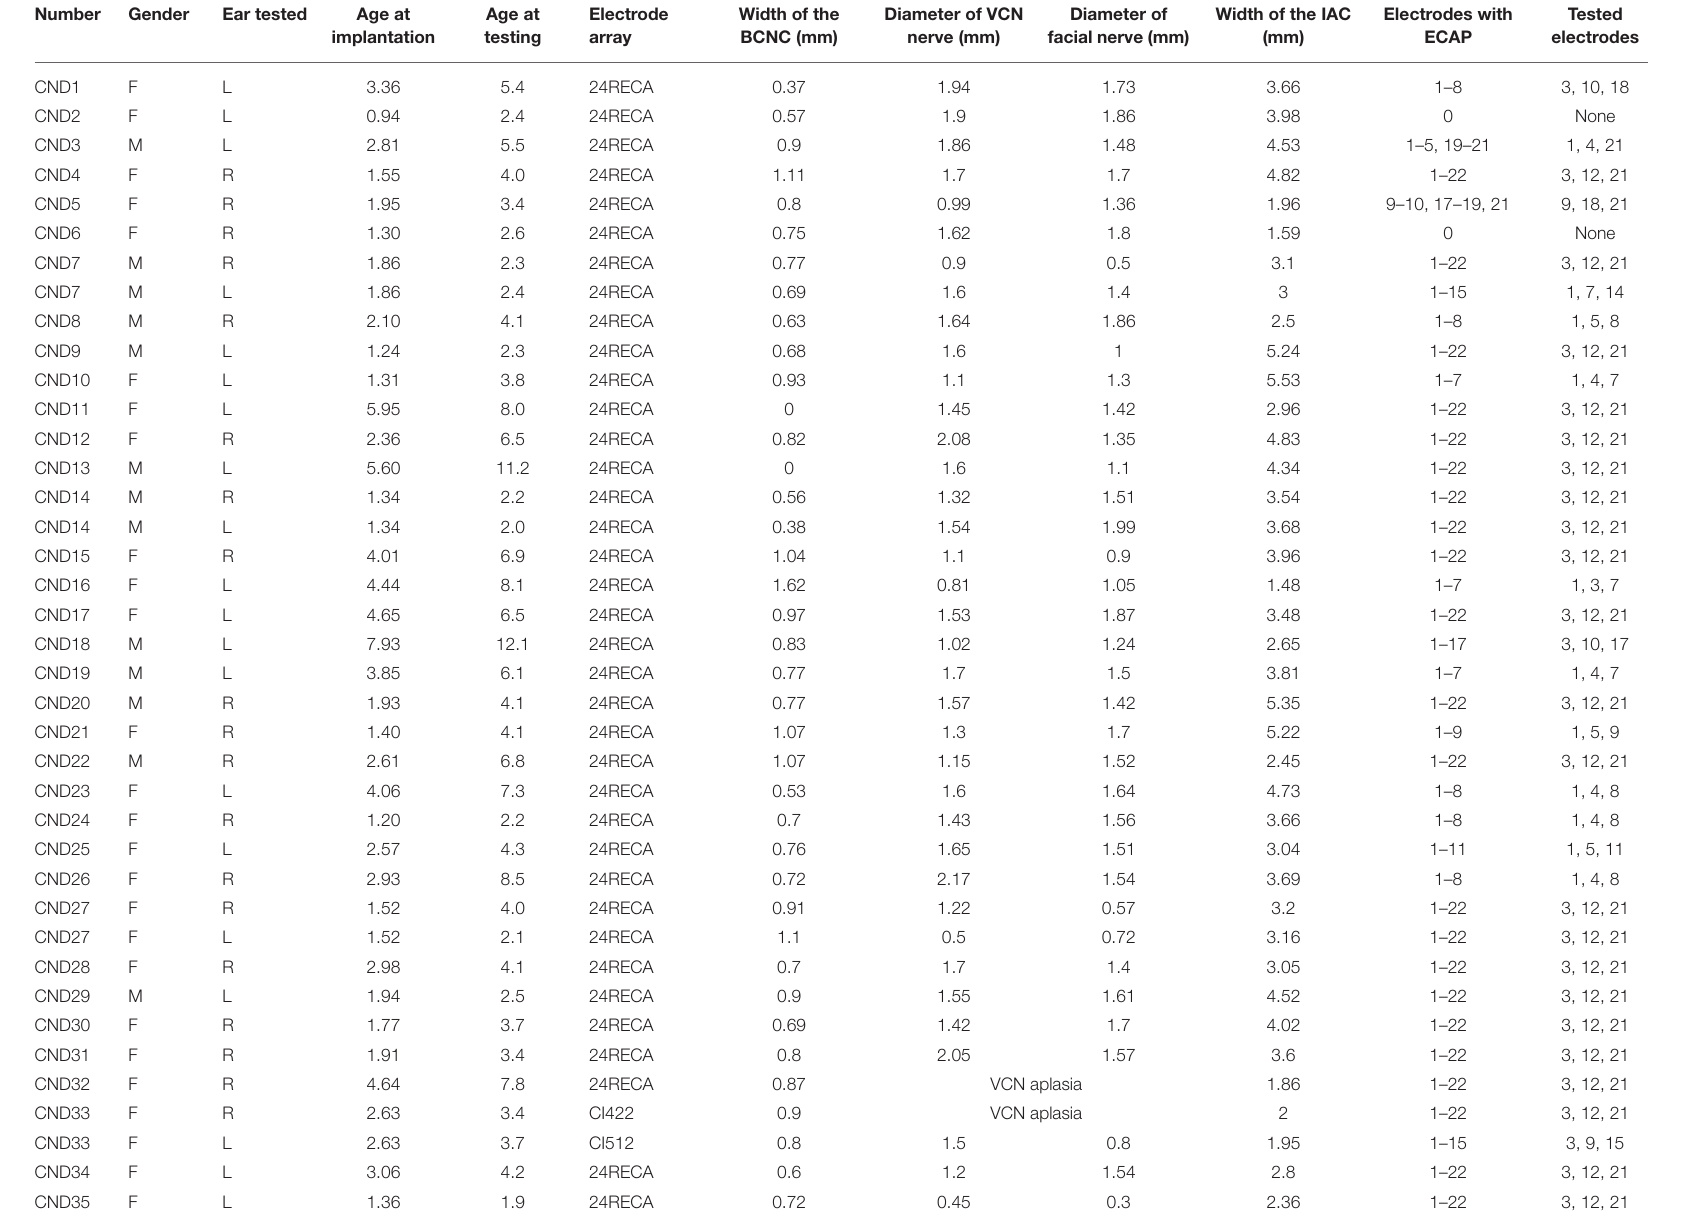
TABLE 1 | Demographic information, imaging results and tested electrodes for each